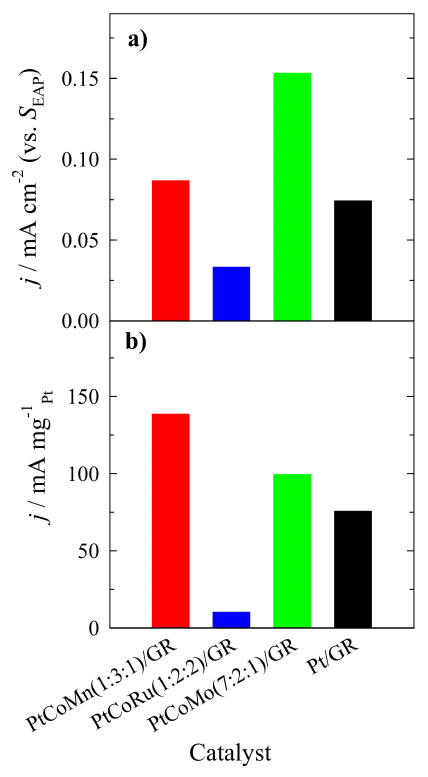
Figure 9. Bar columns represent PtCoMn(1:3:1)/GR, PtCoRu(1:2:2)/GR, and PtCoMo(7:2:1)/GR catalysts specific ( a ) and mass ( b ) activity values in a 1 M CH 3 OH + 1 M NaOH solution, at E = − 0.2 V, t = 1800 s.